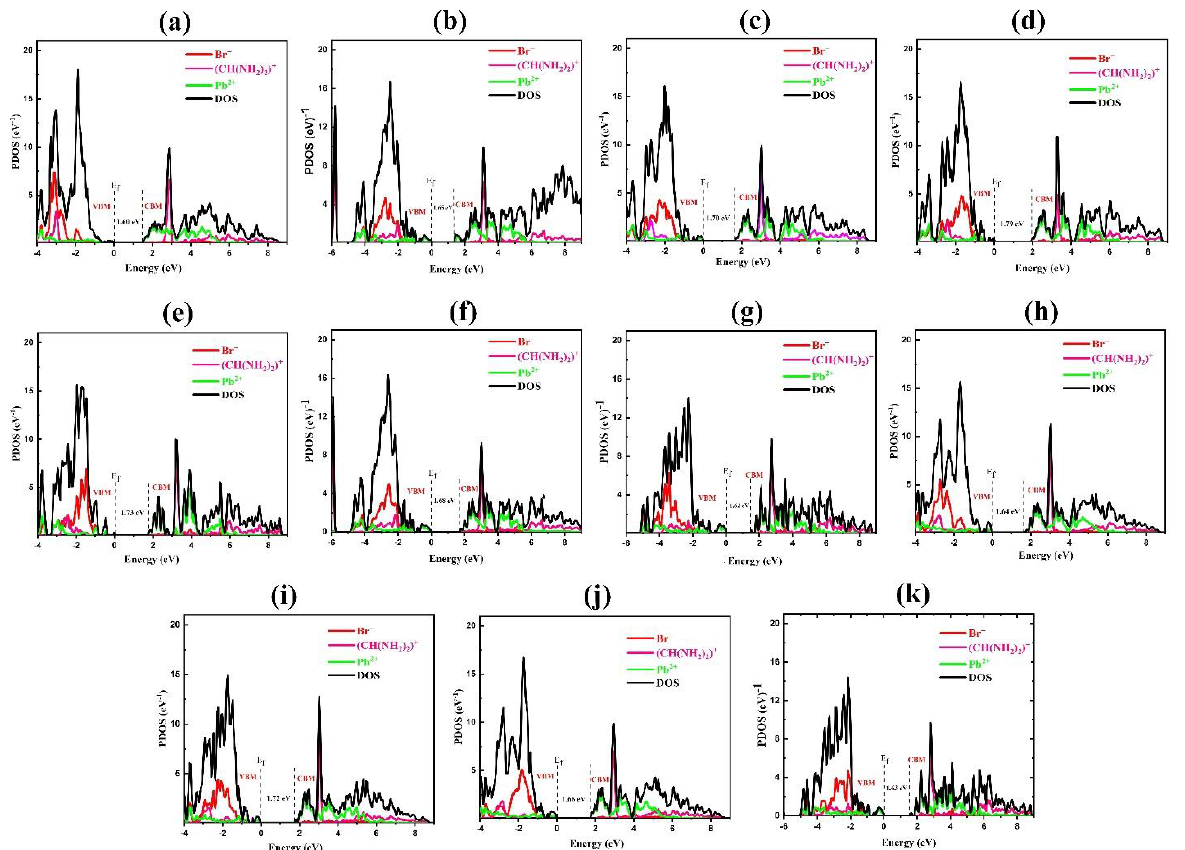
Figure 6. Calculated DOS and PDOS of FAPbBr 3 perovskite for rotational modes of ( a ) 0°-X, ( b ) 15°-Y, ( c ) 30°-Y ( d ) 45°-Y,